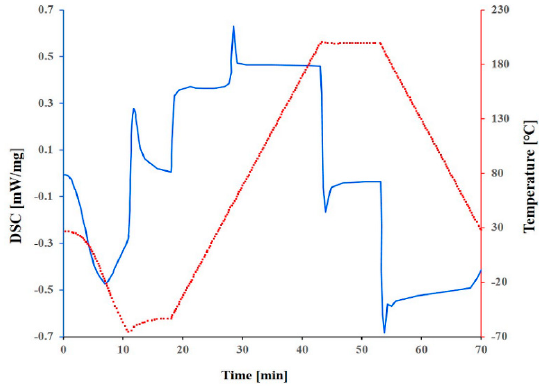
Figure 5. Thermogram of Purasorb PDLG 5010.